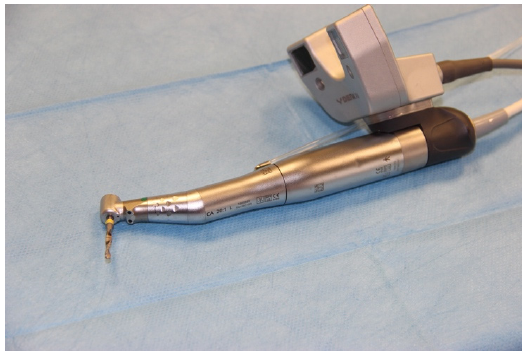
Figure 1. Surgical handpiece with camera attached.